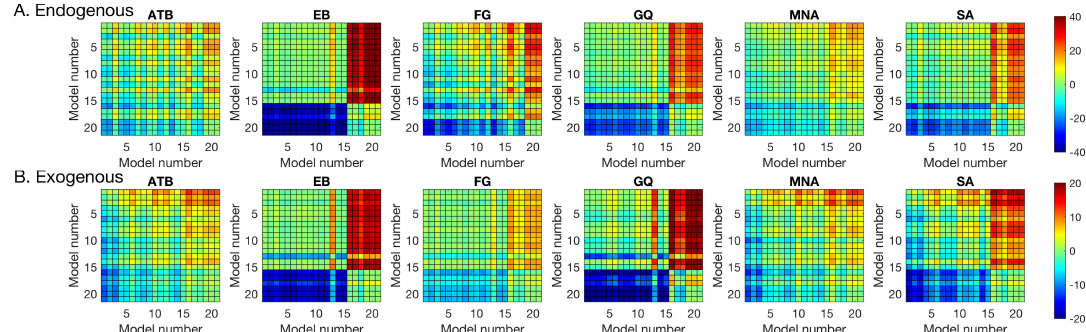
Figure 4. The Bayesian Information Criterion (BIC) differences between each pair of the regression models listed in Table 2. ( A ) Endogenous attention condition. ( B ) Exogenous attention condition. Greenish colors represent equivalent model performance whereas blue and red colors represent better and worse model performance, respectively, in comparing the model listed on the y axis to the model listed on the x